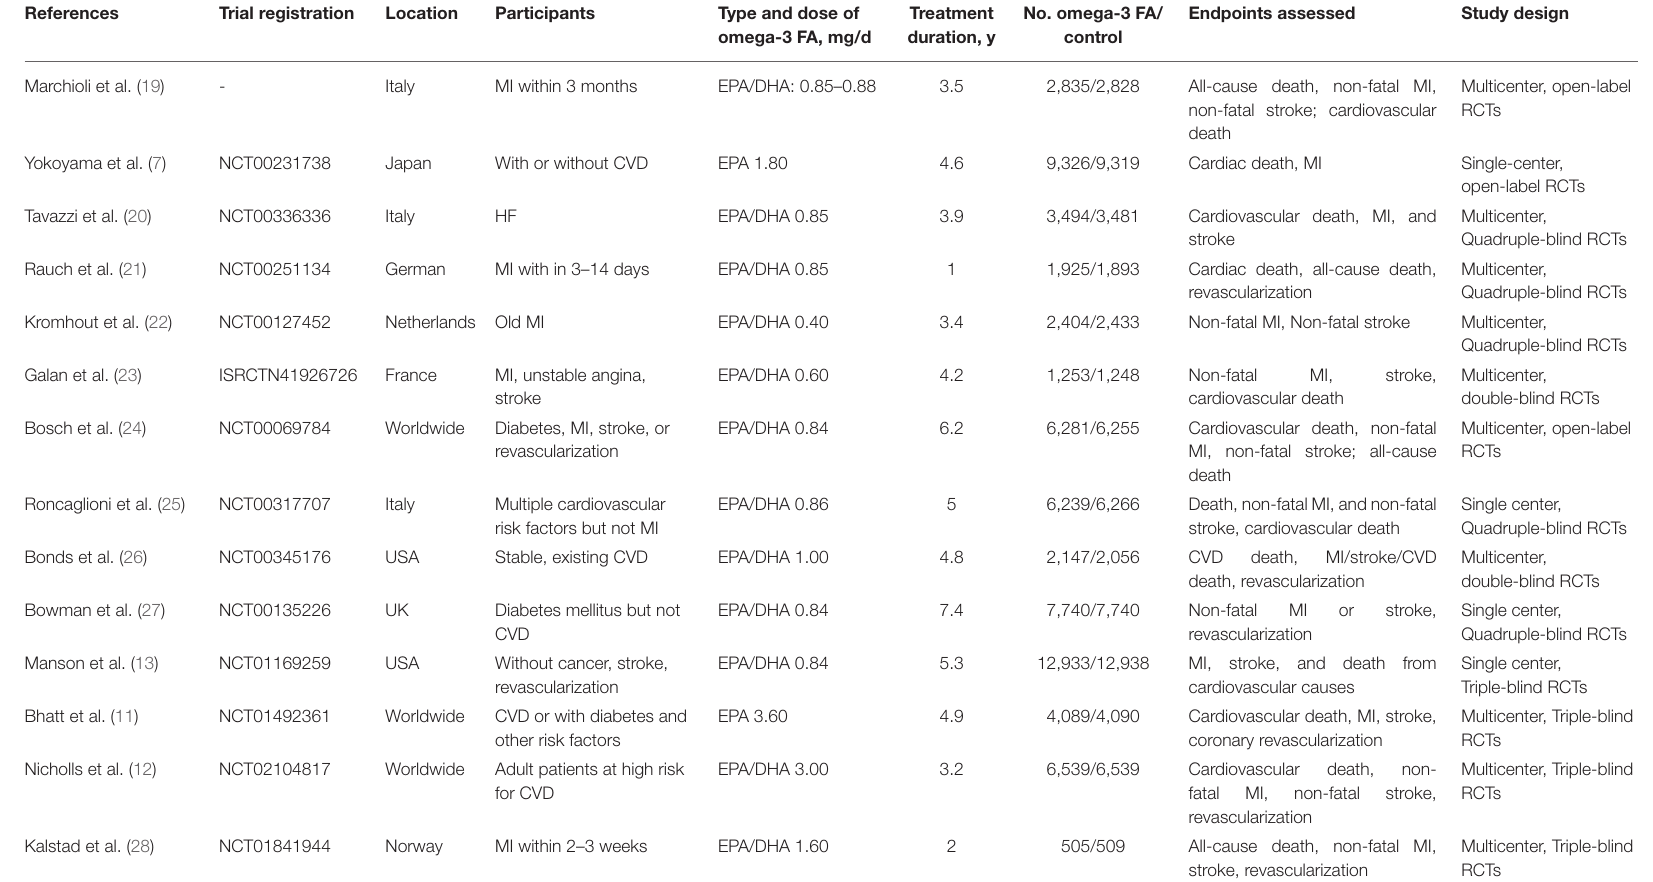
TABLE 1 | Main characteristics of included